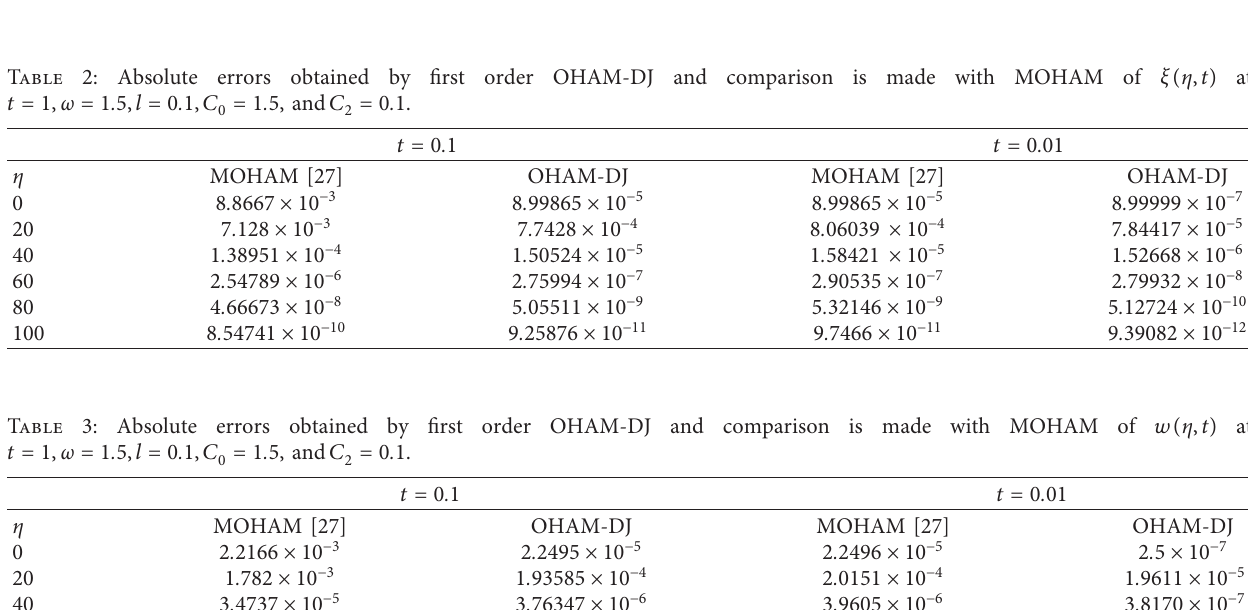
� 1 . 5 , and C � 0 . 1. 0 2 t � 0 . 1